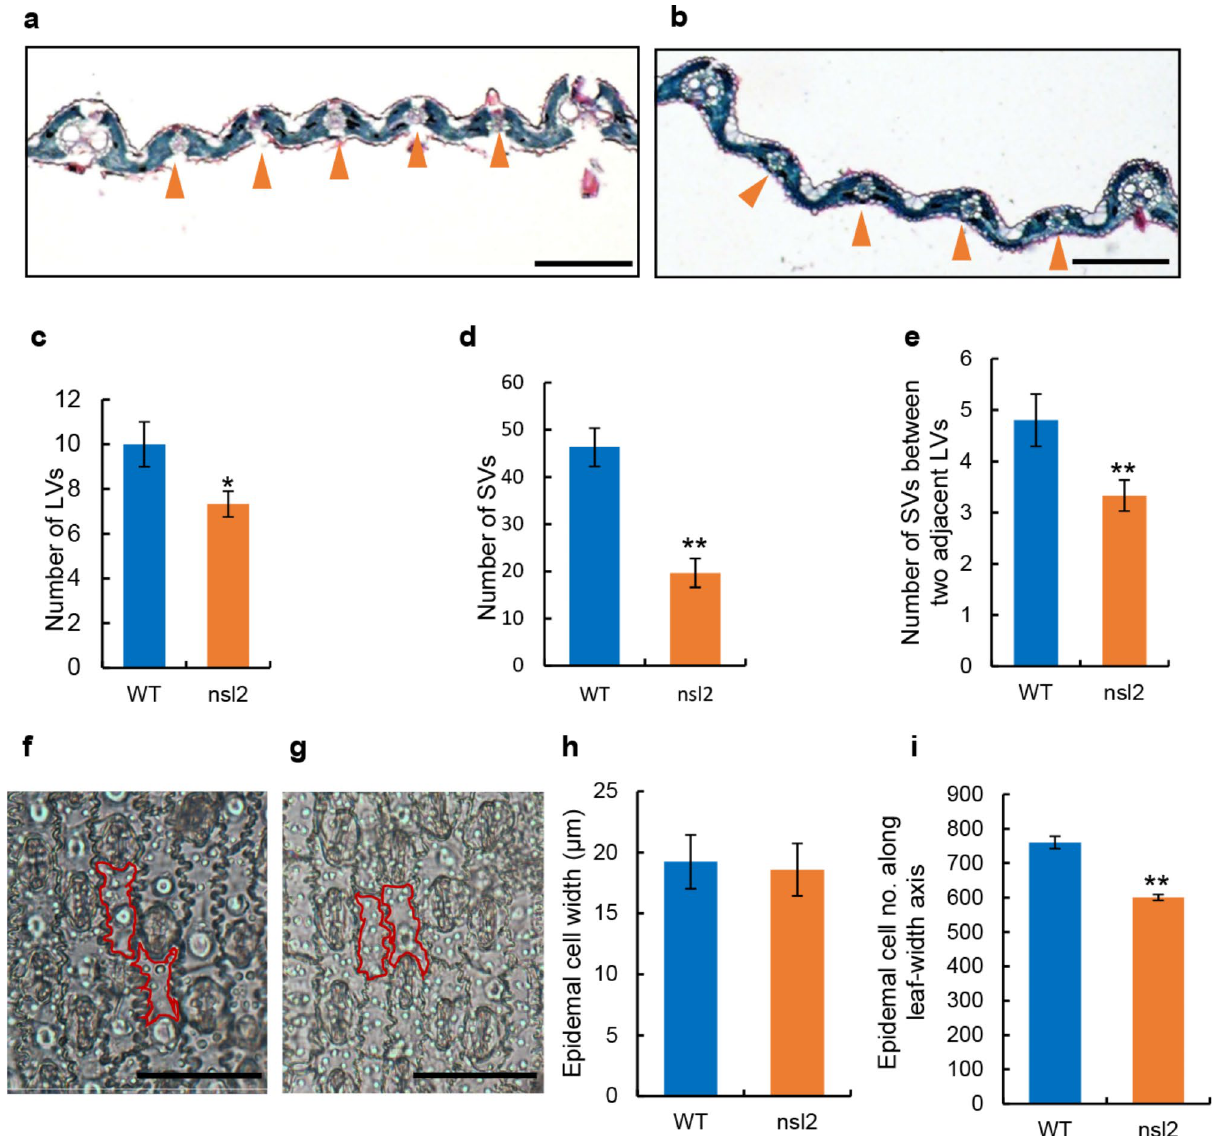
Fig. 2 Histological analysis of WT and the nsl2 mutant. a and b : Transverse sections of the expanded leaves of WT (a) and nsl2 (b). c-e : Comparison of the number of large vascular bundles (LVs) (c) and small vascular bundles (SVs) (d), the number of SVs between two adjacent LVs (e). f and g : The abaxial epi- dermis of leaf blade of WT (f) and nsl2 (g). h and i : Comparison of the epidermal cell width (h), and the epidermal cell number along leaf-width axis (i) of WT and nsl2 . Bars (a-b) 200 μm; (f-g) 50 μm. Values are means ± SD (n = 10 leaves). The P-values were determined using Student’s test. *P < 0.05, **P <